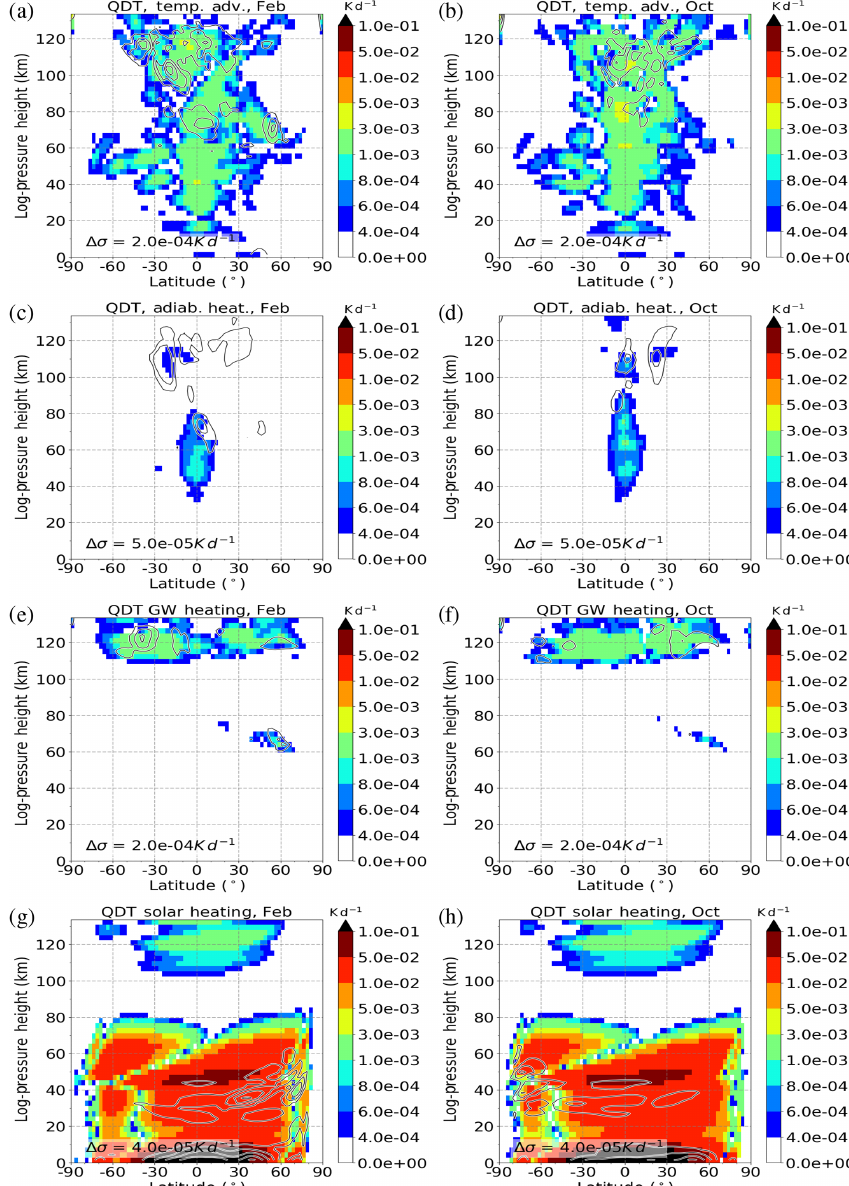
Figure 3. Quarterdiurnal component of thermal tendency terms in the REF simulation for February conditions (a, c, e, g) and October conditions (b, d, f, h) . Amplitudes are scaled by exp [− z( 2 H) − 1 ] . Results are an average of the 11 ensemble members (shaded color). Standard deviations ( σ ) are added as gray contour lines. Panels (a) and (b) show temperature advection (nonlinear component), panels (c) and (d) show adiabatic heating (nonlinear component), panels (e) and (f) show heating due to gravity wave activity (tendency term from gravity wave parameterization), and panels (g) and (h) show solar heating (tendency term from solar radiation parameterization). Note that the color scales are different and that the scale in panels (g) and (h) is not